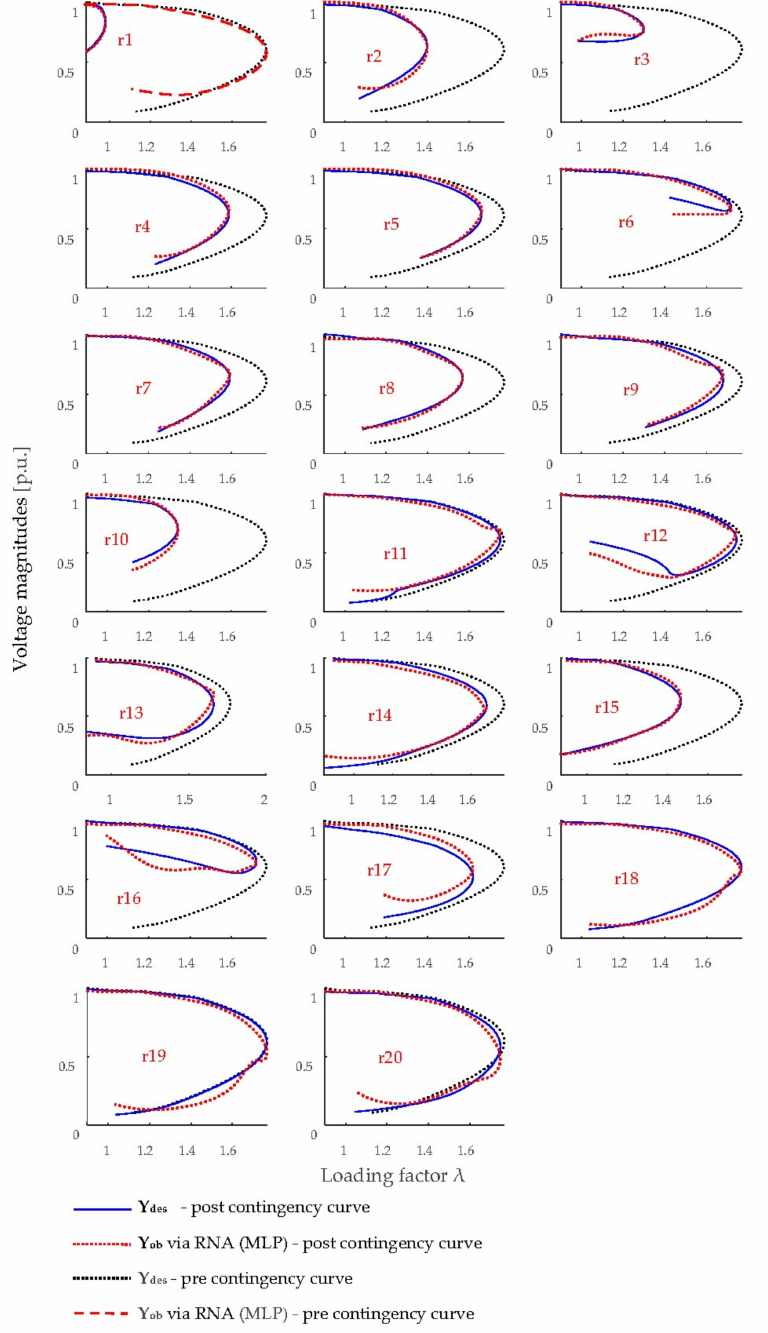
Figure 7. Desired output ( Y des ) and obtained output ( Y ob ) by the MLP network, P-V curves for all contingencies r of the system for bus